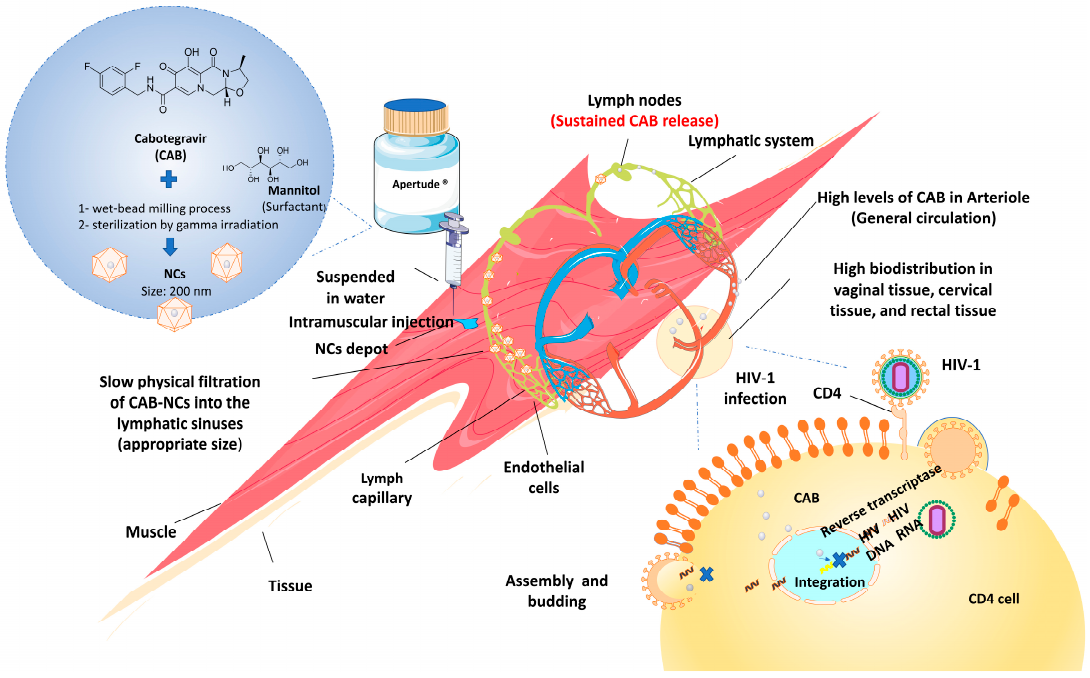
Figure 2. Mechanism action of Apretude (CAB-NCs) to inhibit the HIV-1 viral replication. After an intramuscular injection, CAB-NCs highly distribute in vaginal, cervical, and rectal tissue, where they bind to the active integrase site and inhibit the retroviral deoxyribonucleic acid (DNA) integra- tion phase, which is required for the HIV replication cycle .